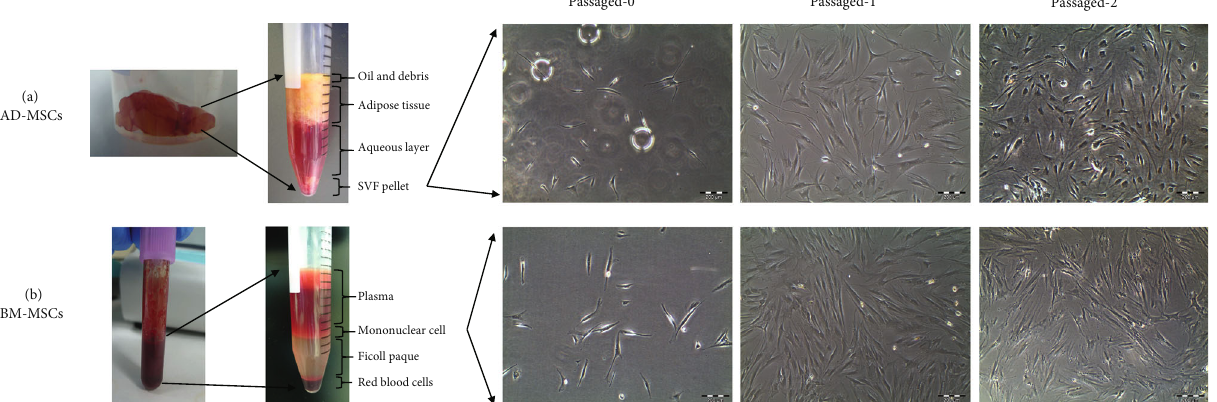
Figure 1: Morphology of isolated human AD-MSCs and BM-MSCs from adipose fat pad and bone marrow, respectively. (a) Enzymatic digestion of adipose tissue using collagenase type I, and the MSCs population isolated from the SVF. (b) MSCs isolated from bone marrow and the mononuclear cells isolated by Ficoll density centrifugation. At primary culture passage-0 (Day 6), fi broblastic as well as small clear cells can be observed. The number of clear cells was reduced during the passages and fi broblastic cells appeared to be the dominant cell